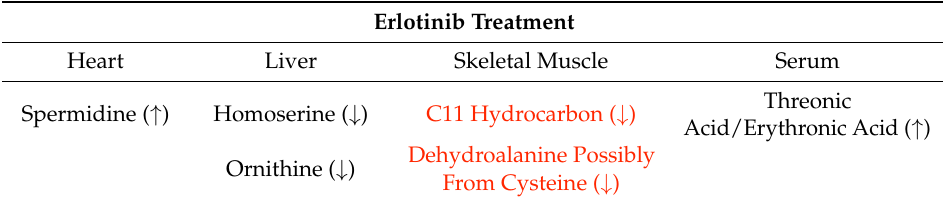
Table 3. t -test significant metabolites in erlotinib-treated tissues compared to vehicle control treated. Color-matched metabolites are highlighted if they were found in two or more tissues (blue) or in the same tissue by both drugs